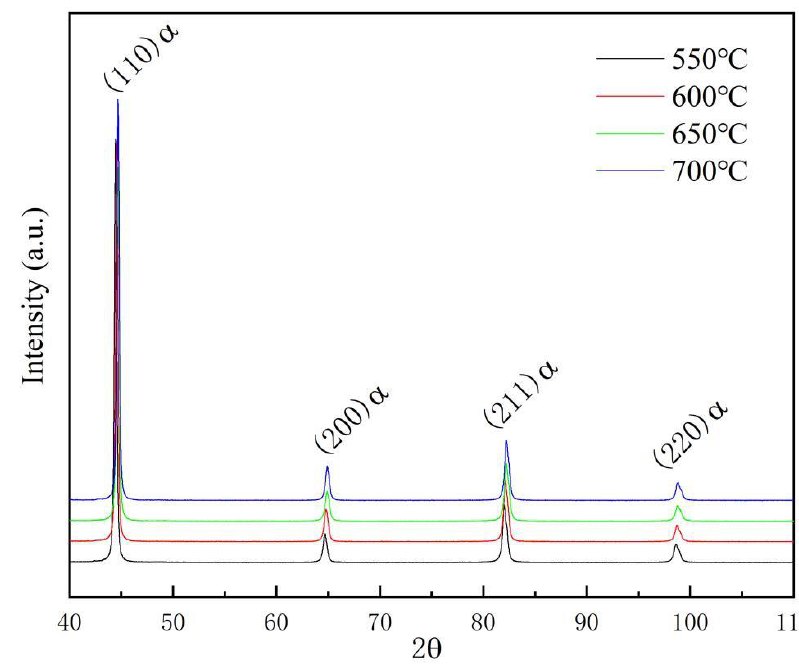
Figure 9. XRD patterns of heavy-wall seamless bend pipe steel after tempering. Table 3. Mechanical properties of studied steel after different tempering